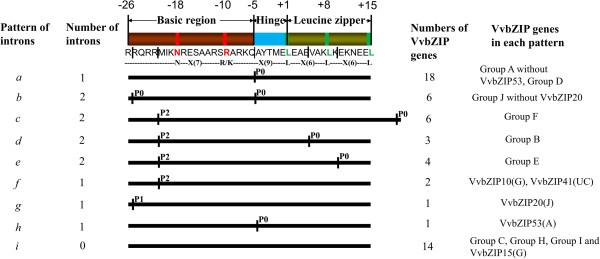
A schematic diagram of intron patterns in the grapevine bZIP gene family. The primary structure of the bZIP domain is shown at the top of the picture. The basic region, hinge and leucine zipper were shaded in crimson, blue and green, respectively. The highly conserved residues are highlighted with red and light green boxes. An example of the consensus sequence is given below, and the corresponding positions are shown at the top of the bar [45]. Leucines are sometimes replaced by Ile, Val, Phe or Met. The black vertical lines in the bar indicated the intron position within the bZIP domain and P0, P1 and P2 stand for the intron phase 0, phase 1 and phase 2, respectively. The details of intron position within bZIP domain of the VvbZIP genes were shown at Additional file 2.